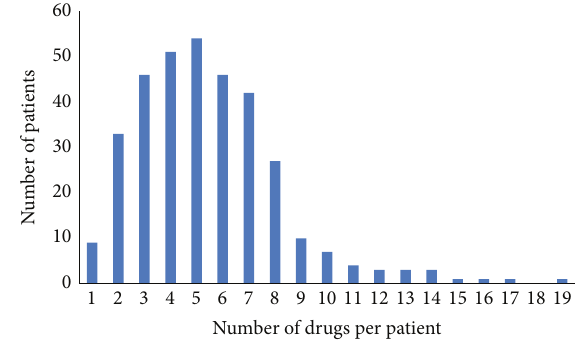
Figure 1: Drug count distribution among patients receiving antiepileptic and/or tricyclic antidepressant drugs ( 𝑁 = 342 ).